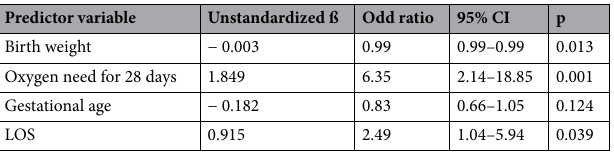
Table 3. Results from the logistic regression analysis predicting likelihood of any grade